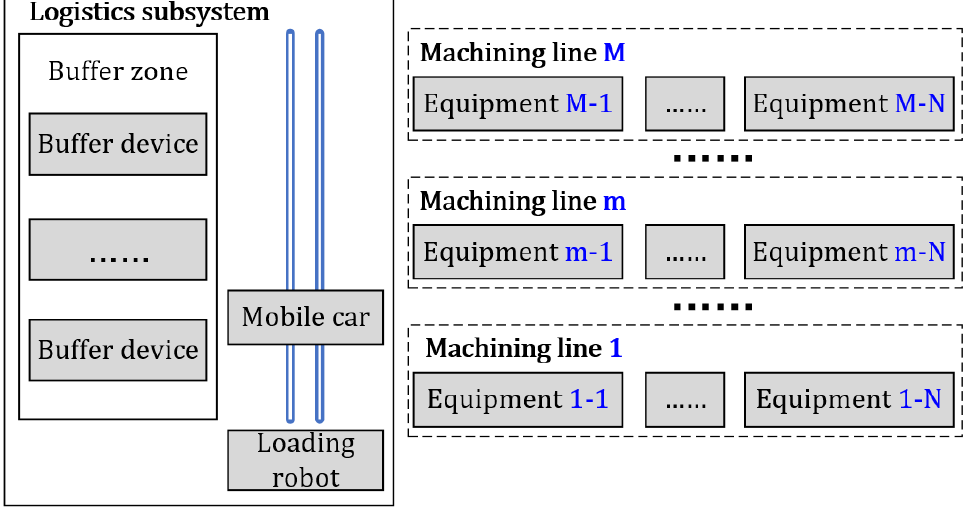
Figure 2. A classic layout of a FMS.